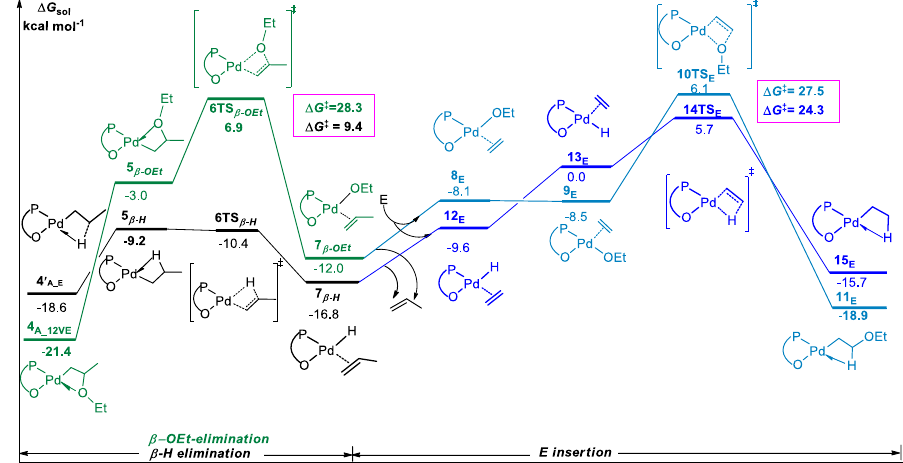
Figure 6. Energy profiles for β -H and β -OEt elimination and chain re-growth.